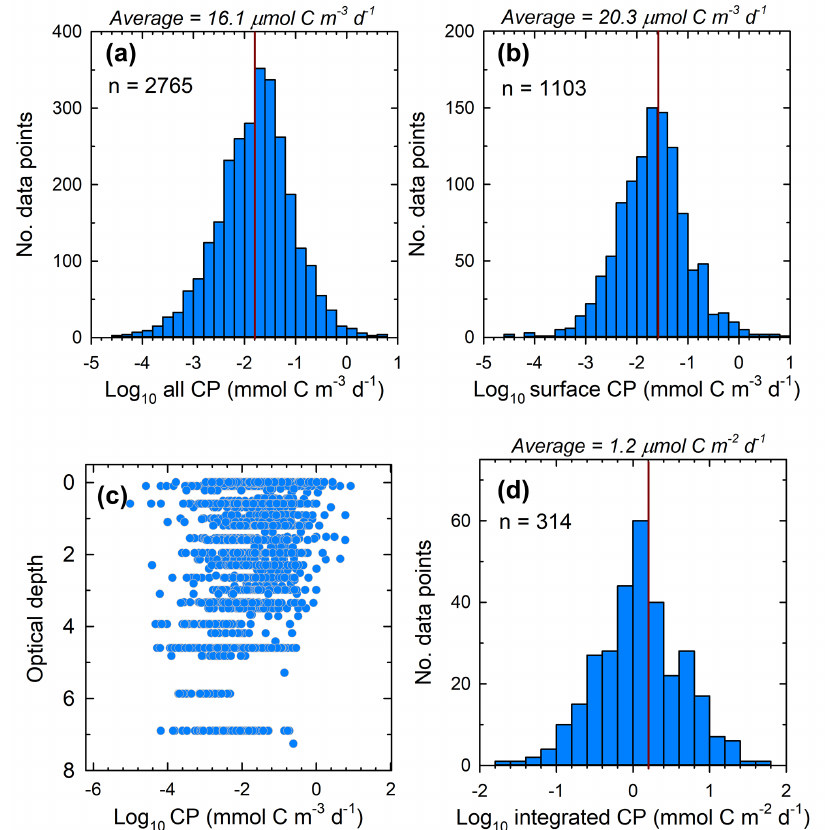
Figure 4. Characteristics of the CaCO 3 production (CP) database: (a) measurement frequency versus all log-normalised CP data, (b) mea- surement frequency for log-normalised surface CP data only, (c) all log-normalised CP data versus optical depth and (d) measurement frequency for log-normalised euphotic zone integrated CP. Panels (a) , (b) and (d) have geometric means presented.